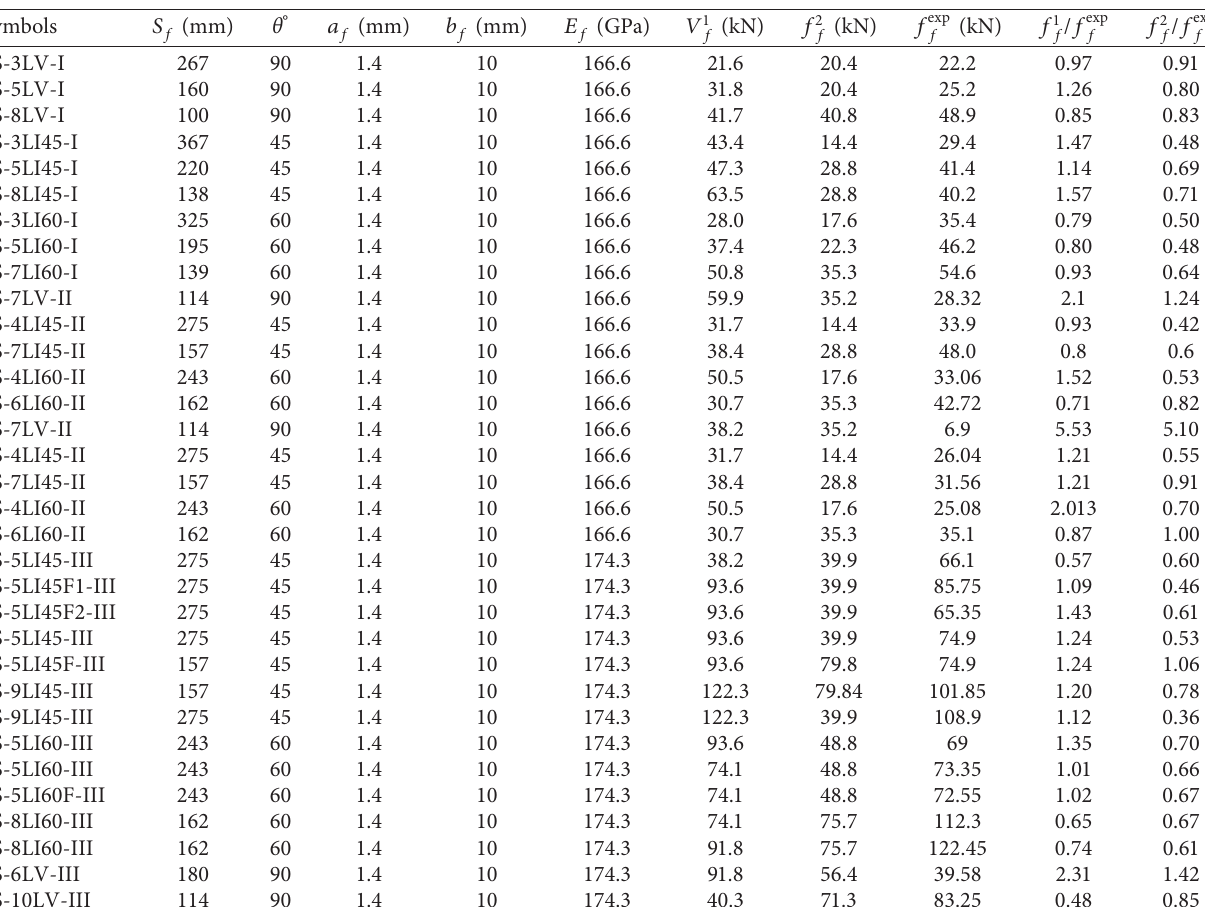
Table 2: Comparison between experimental results [27] and analytical results. Symbols